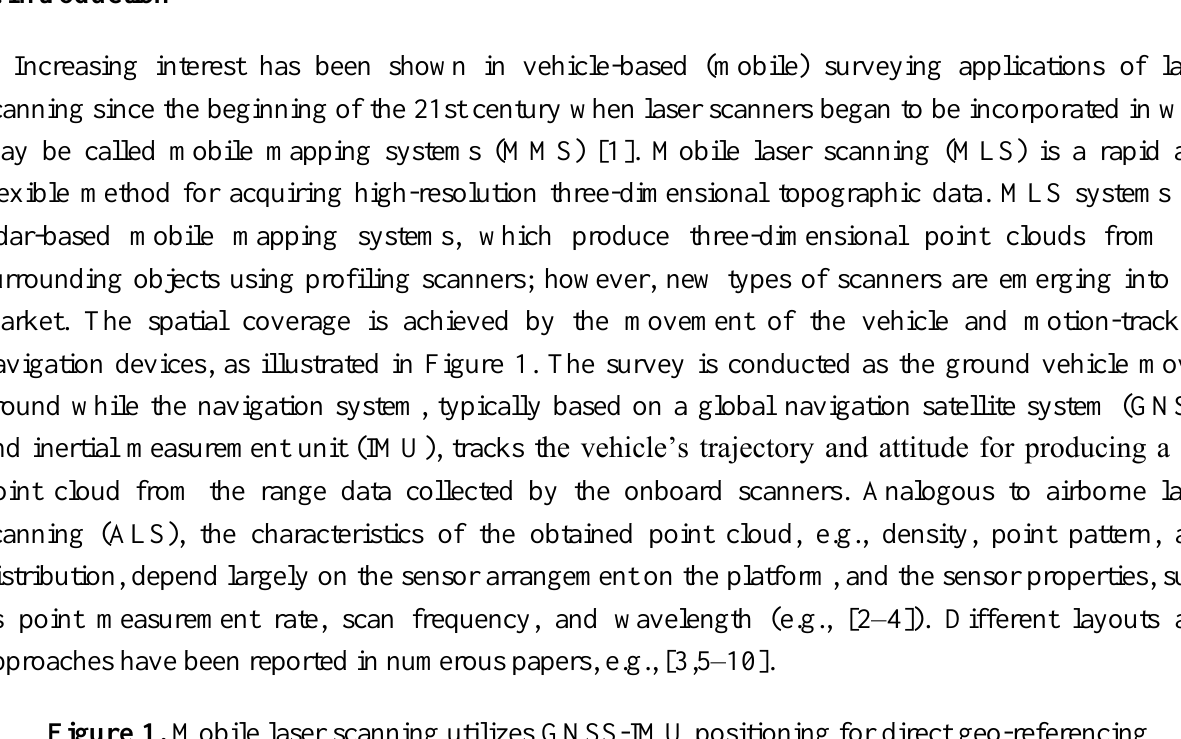
Figure 1. Mobile laser scanning utilizes GNSS-IMU positioning for direct geo-referencing of laser scanning data for three-dimensional mapping of